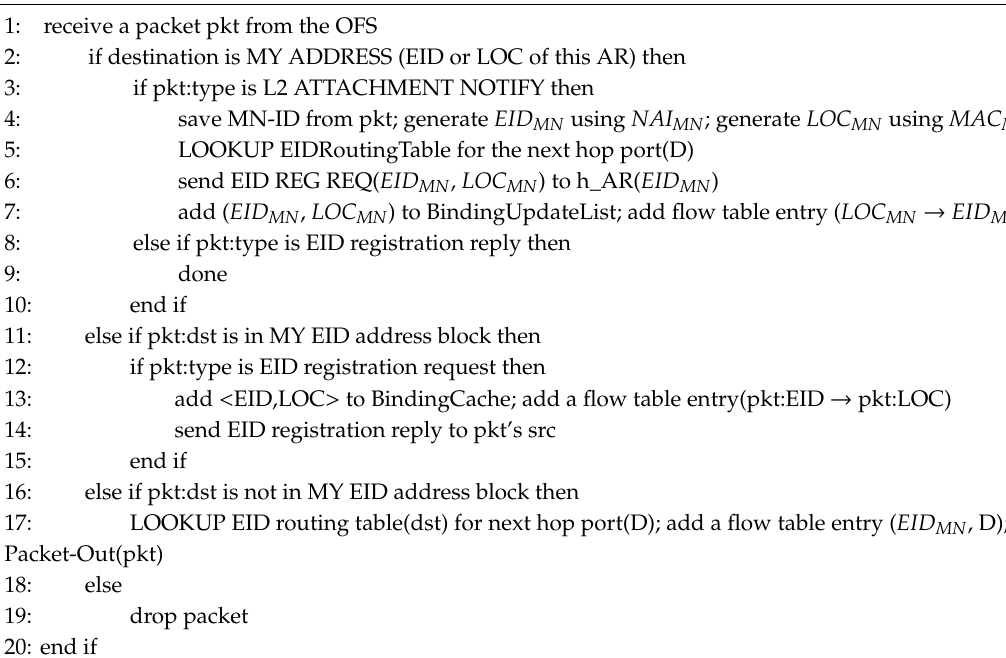
Algorithm 1. Registration and Packet